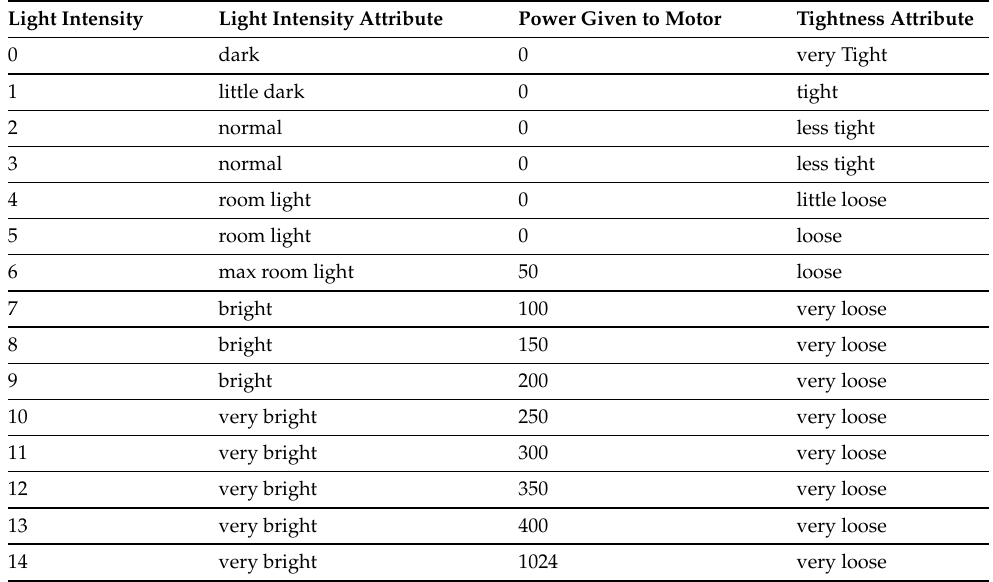
Table 8. Mapping of the intensity to the power of rotation of DC